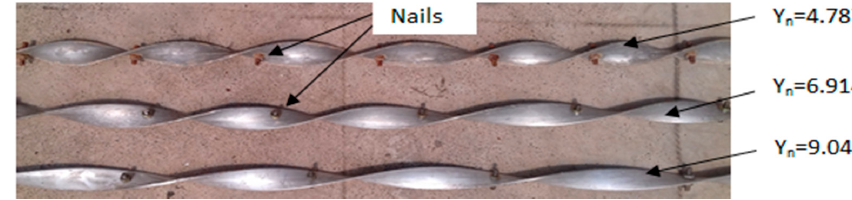
Figure 4. Photographic view of NTT.